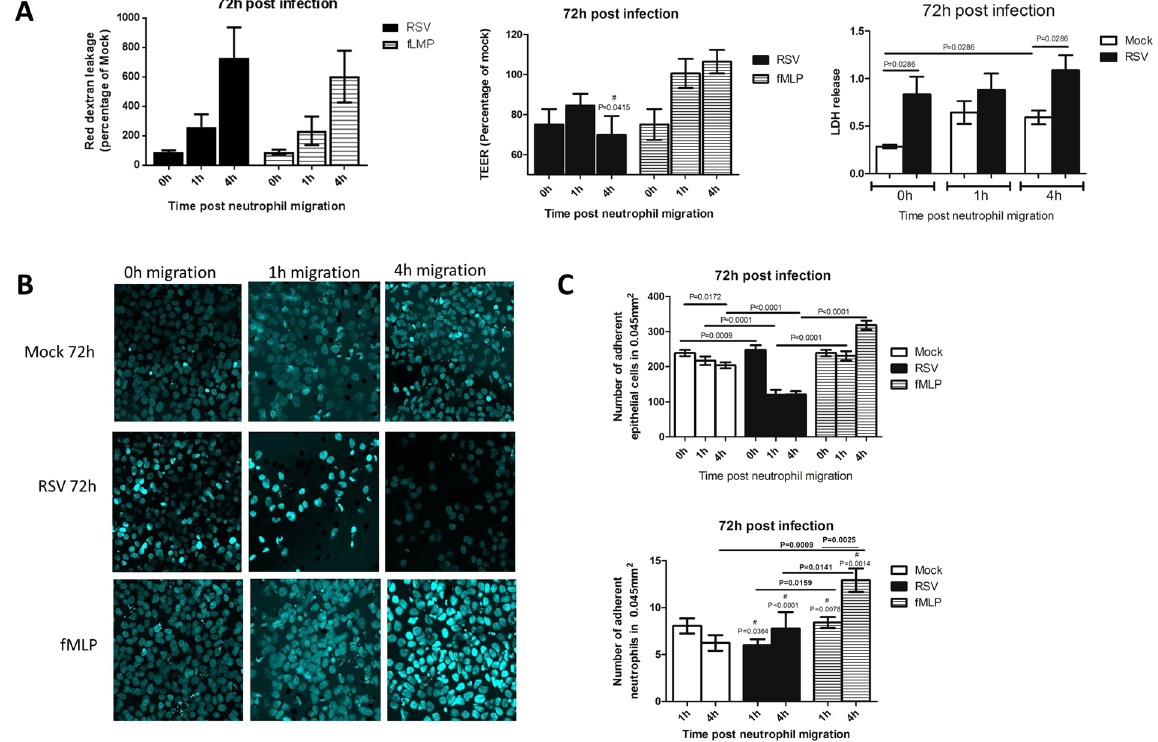
Figure 7. Neutrophil migration increases damage to epithelial monolayers infected with RSV for 72 hours. (A) The damage caused to the A549 epithelium following neutrophil migration through cells infected with mock or RSV infection for 72 hours as determined by i) Red-dextran leakage from basal-apical compartments, data represented as the percentage relative to the mock infected control n = 4 ii) TEER as measured using a voltohmmeter, data is represented as the percentage relative to the mock infected control n = 9 iii) Lactate dehydrogenase (LDH) release as measured in apical supernatant of AECs post neutrophil migration. The neutrophil chemoattractant N-Formylmethionine-leucyl-phenylalanine (fMLP) was used as a positive control. Bars show mean ± SEM of at least n = 3 biological repeats. (B) Representative microscopy images of A549 epithelial monolayers infected with RSV for 72 hours stained with a nuclei stain (Hoechst) following neutrophil migration after 1 or 4 hours. (C) Epithelial cell and neutrophil nuclei were counted in ImageJ and the average number of nuclei from all images was calculated. Bars show mean ± SEM of n = 5 biological repeats. Statistical significance is shown. A hash (#) indicates a significant (P < 0.05) difference was found when compared to the equivalent data collected at 24 hours post infection (Fig. 6). For all other comparisons P >